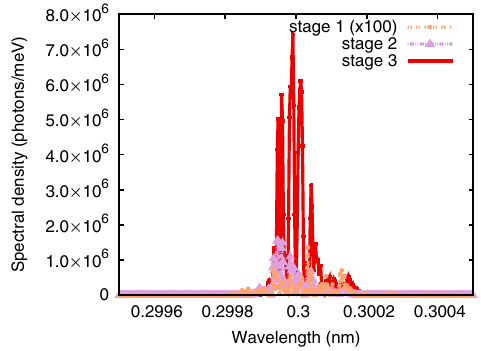
FIG. 23. Spectrum of the 4 keV part of the radiation for at end of stage 1 (scaled up by a factor of 100), stage 2 and stage 3 for the start-to-end bunch using a 3-stage configuration.